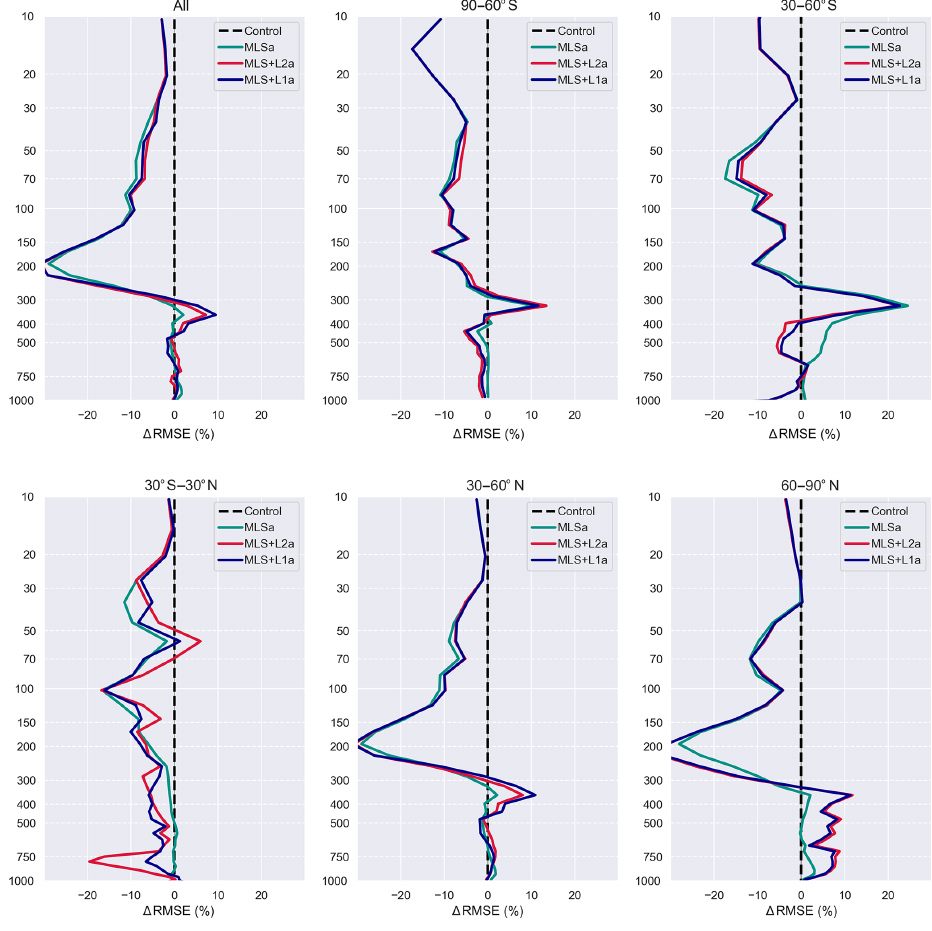
Figure 12. Relative difference of RMSE ( (cid:49) RMSE) with respect to radiosoundings for MLSa (teal), MLS + L1a (dark blue) and MLS + L2a (red). Same plots as in Fig.